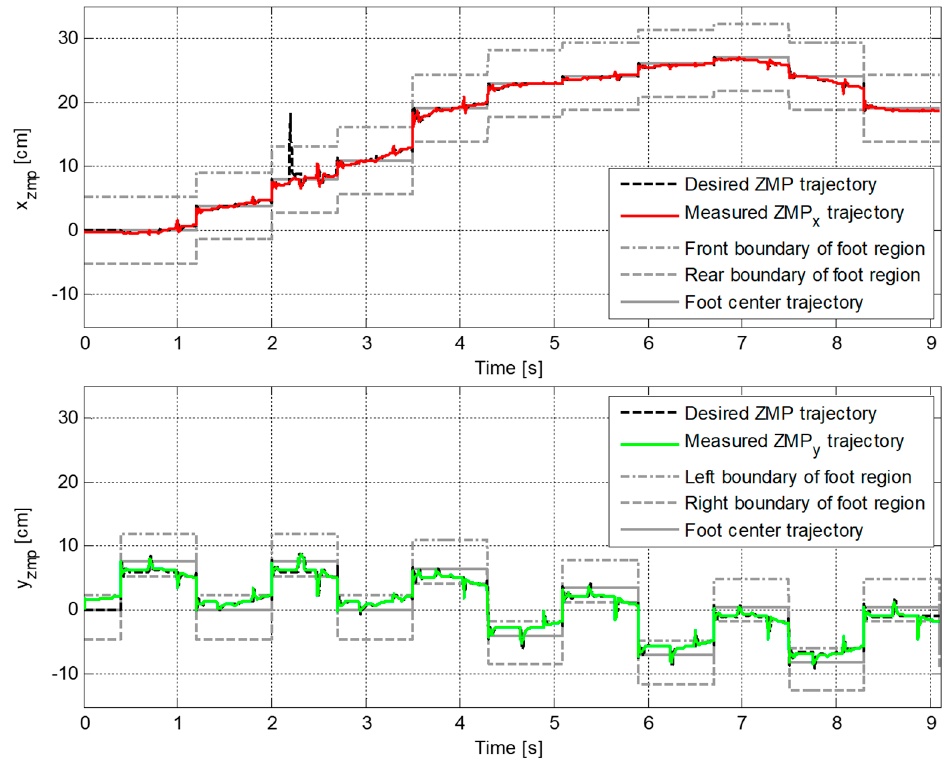
Figure 11. Trajectories of desired ZMP for CP tracking control and measured ZMP, 𝐩 (cid:3031) and 𝐩 (cid:3030) , in the first simulation.